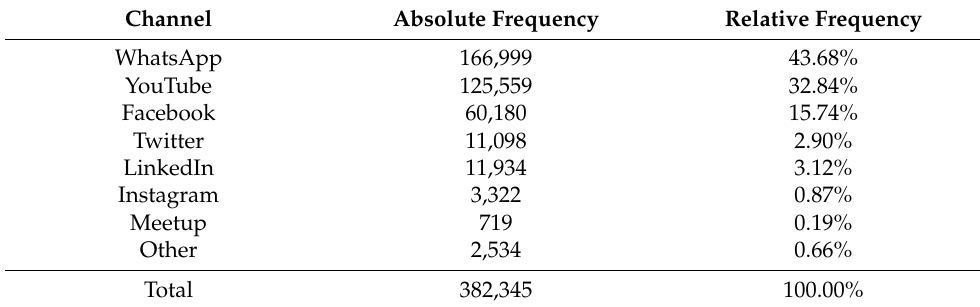
Table 4. Traffic obtained through social